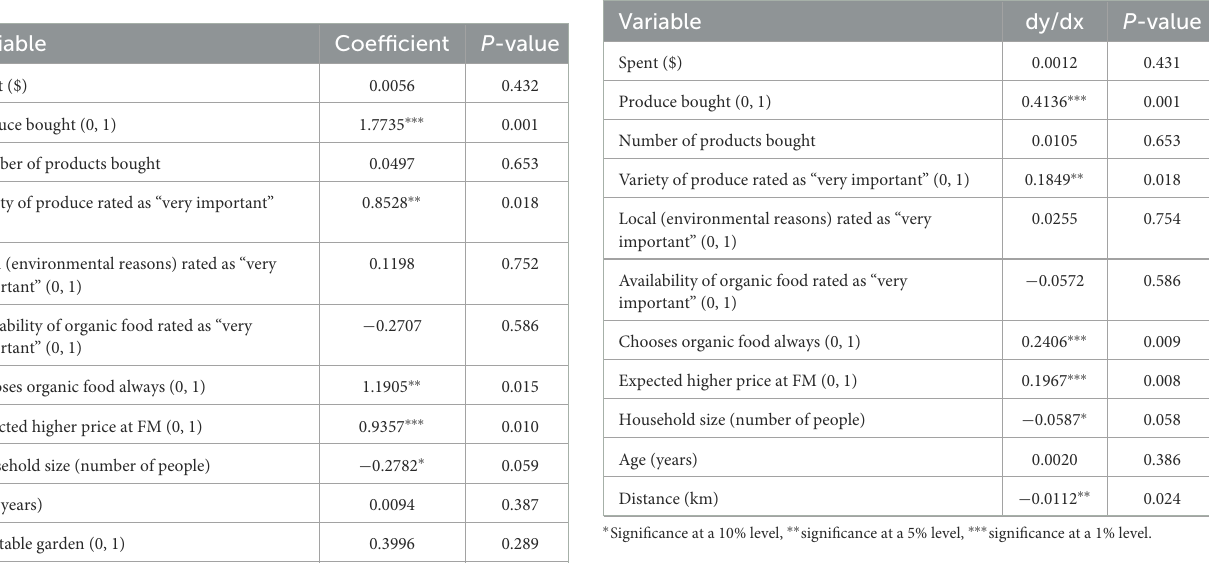
TABLE 9 Marginal effects of logistical regression